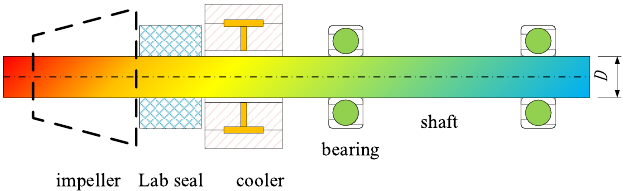
Fig. 1. SCO 2 turbine shafting